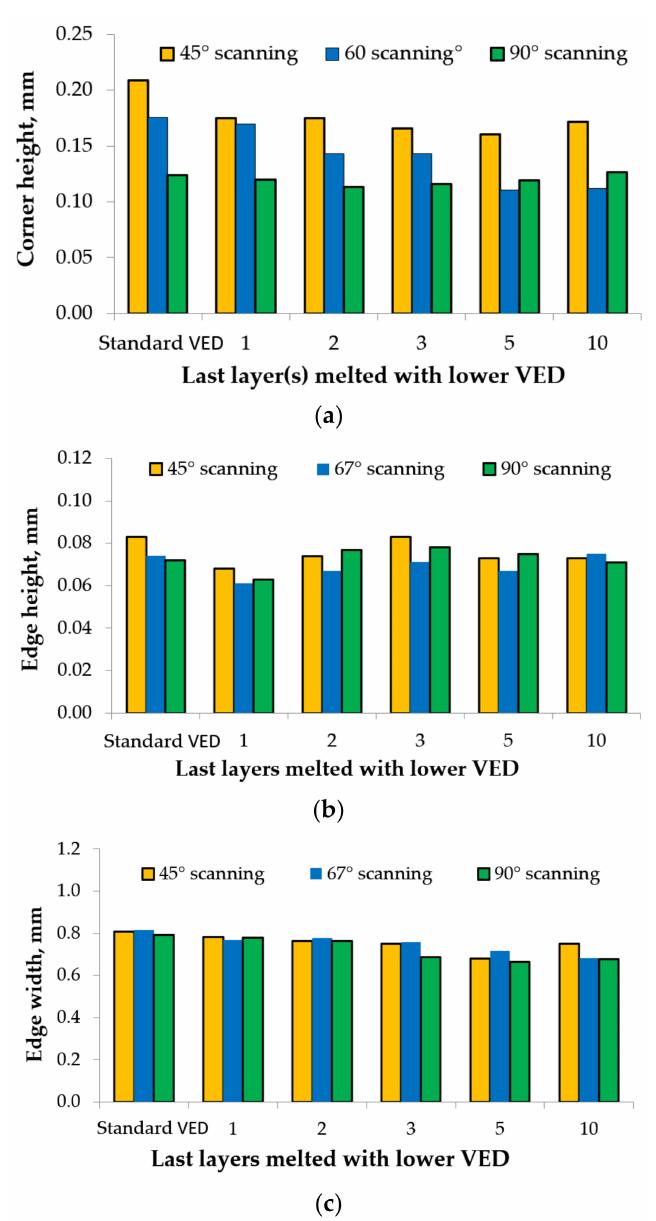
Figure 9. Corner and edge height and width of samples as a function of increasing the number of last layers melted with low